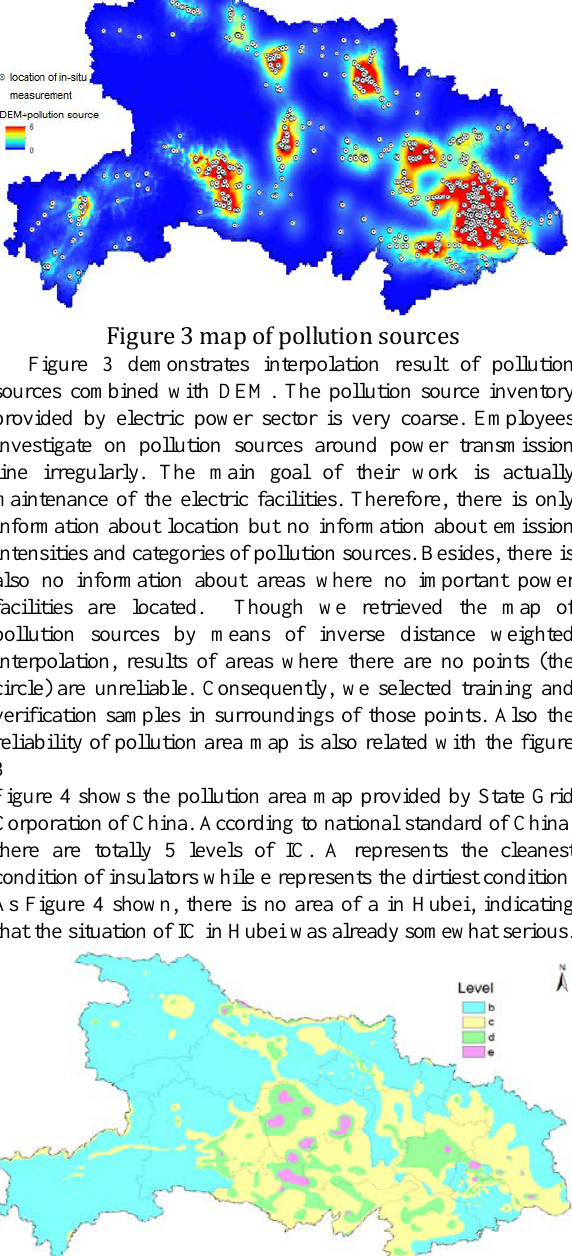
Figure 4 the pollution area map of Hubei provinces in